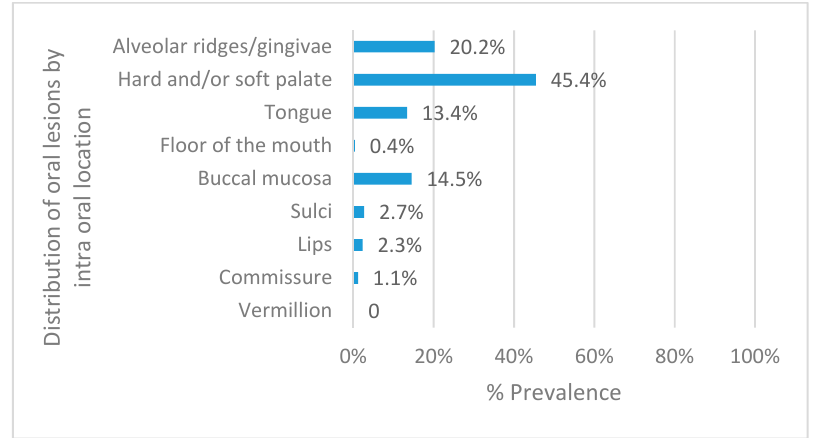
Figure 2. Total prevalence of oral mucosal lesions by intra-oral location.